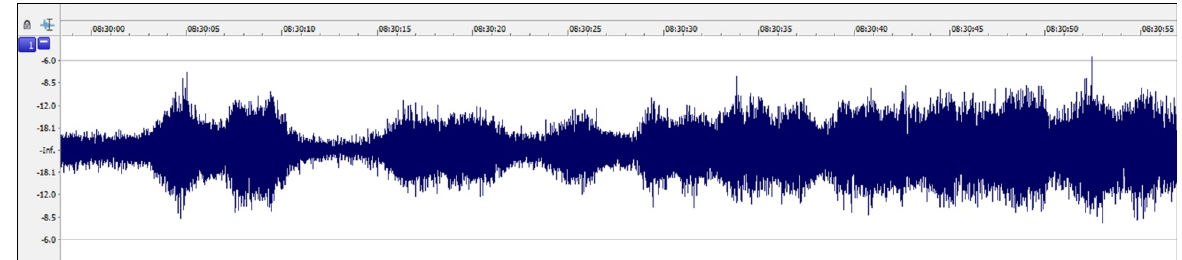
Figure 8. Soundscape map (detail), 8:30 a.m.–8:31a.m., 23 August 2013 (53°18'10.1"N